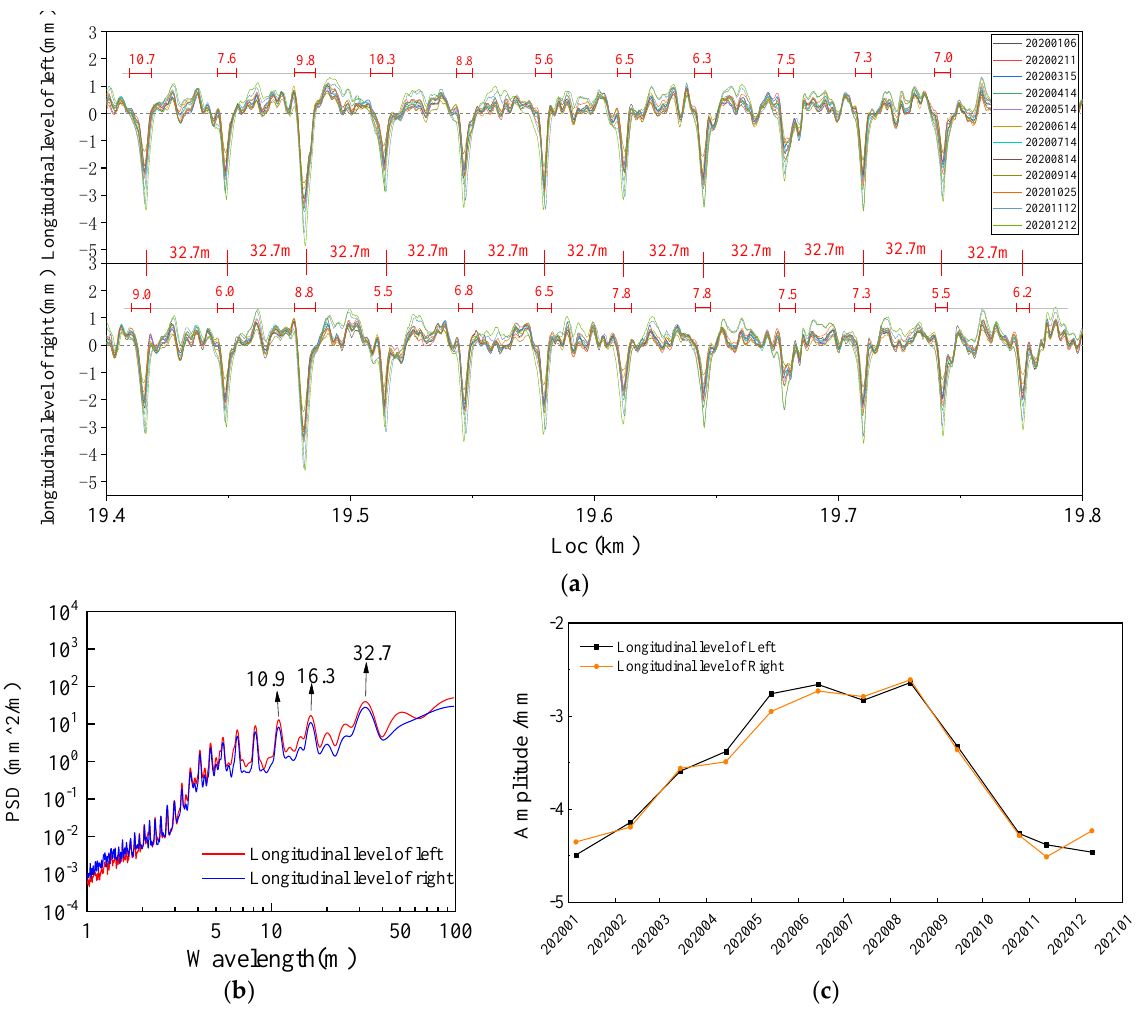
Figure 4. Various characteristics of track longitudinal level. ( a ) Longitudinal level. ( b ) PSD of longitudinal level. ( c ) Longitudinal level at the location of 19.481 km.